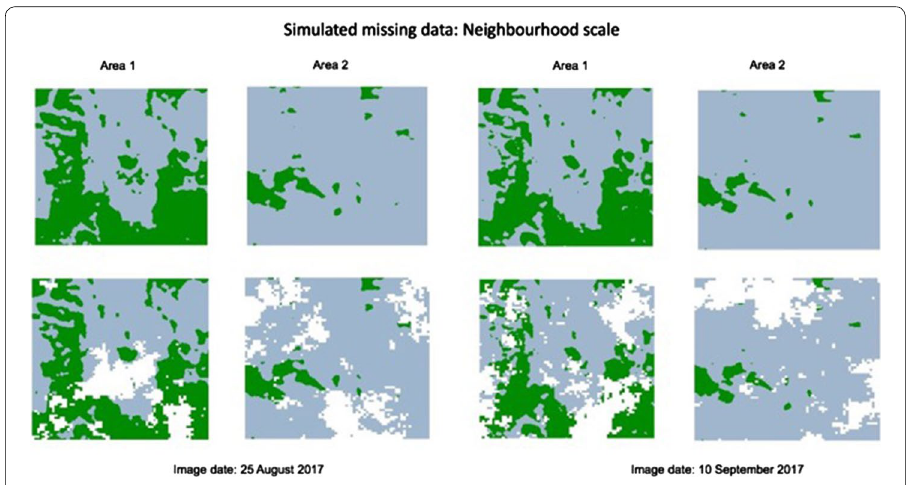
Fig. 5 Binary plots of NDVI for two smaller areas within the Landsat 8 images at neighbourhood scale. White indicates simulated cloud, green indicates forest and grey indicates not forest land